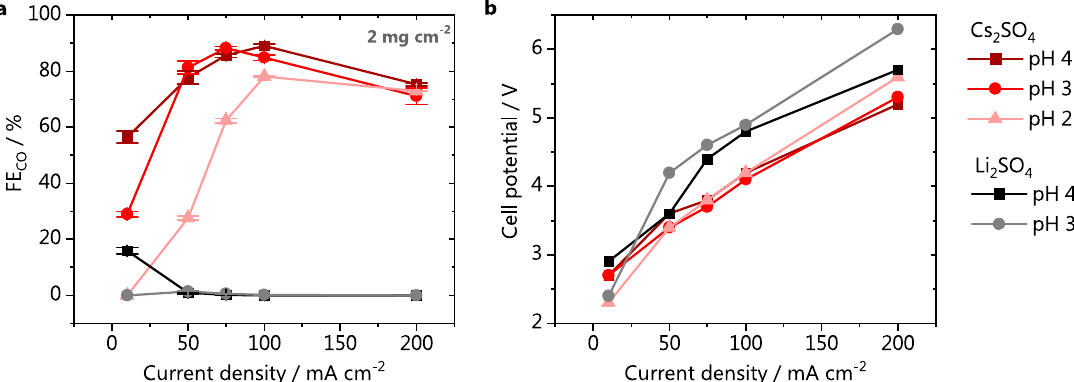
Fig. 2 Effect of pH and cation identity on CO 2 electrolyis. a Faradaic ef fi ciency for CO and ( b ) cell potential. Electrolysis performed in either 1 M Cs 2 SO 4 (red) or 1 M Li 2 SO 4 (gray scale), catalyst loading 2 mg cm −